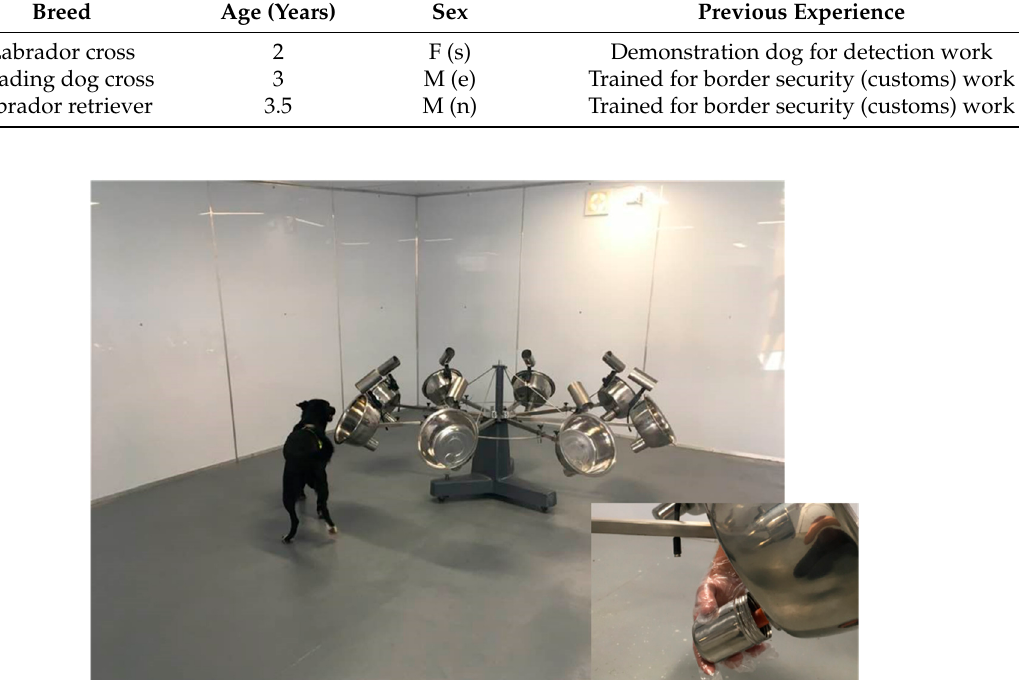
Figure 1. The testing carousel during training with Lillie. The insert lower right shows one of the ports with the sample pot disconnected and the orange cap of a control flask